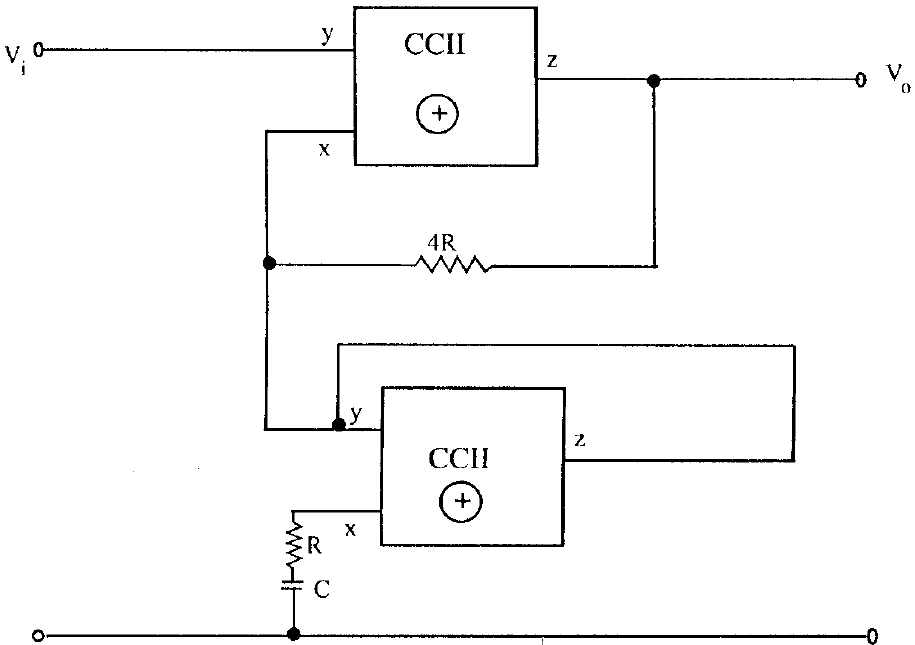
FIGURE 4 A high input impedance first-order all-pass